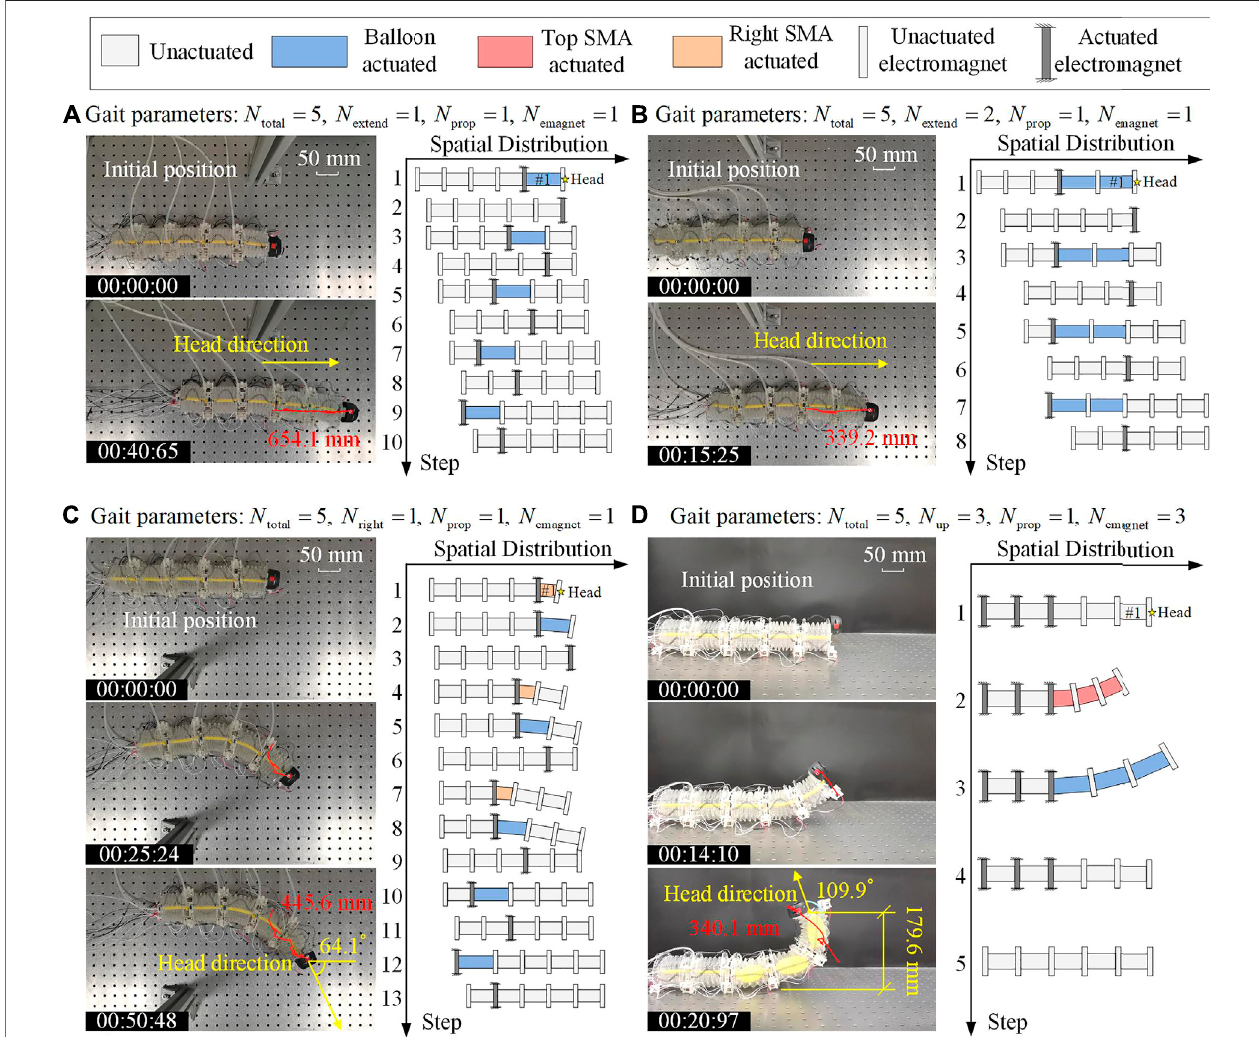
FIGURE 12 | 3D Locomotion tests, demonstrating via the snapshots and the extracted trajectory of the robot locomotion are demonstrated, as well as the corresponding locomotion gaits. (A) Rectilinear locomotion. (B) Rectilinear locomotion with another gait. (C) Right turning of the robot. (D) Rising up of the robot head. For these four locomotion tests, the adopted gait parameters are also